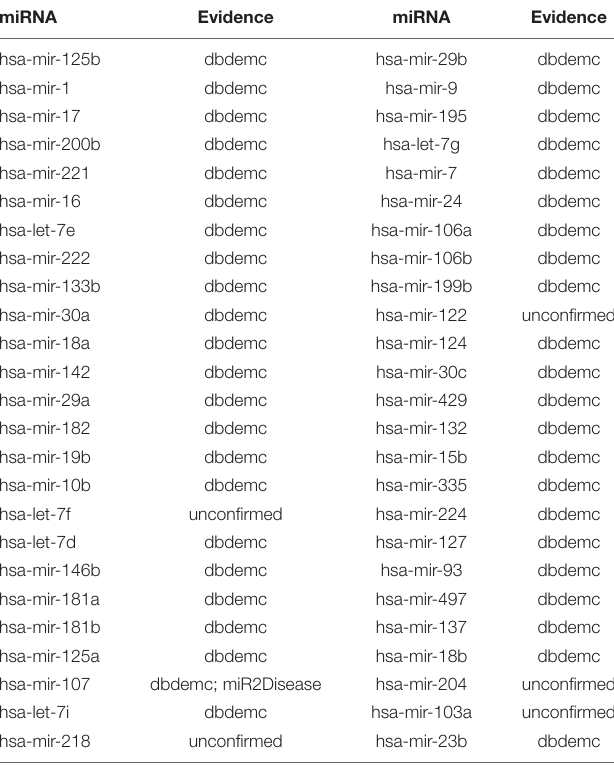
TABLE 4 | Prediction of the top 50 predicted miRNAs associated with